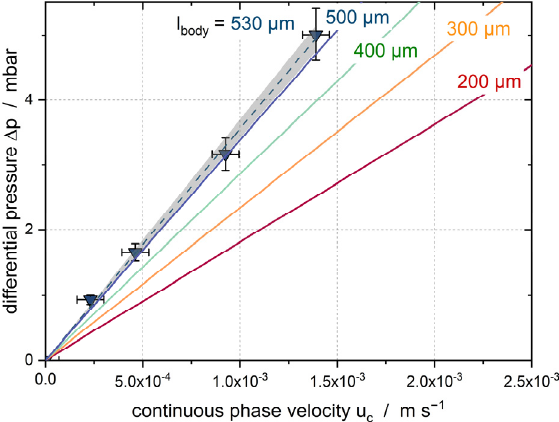
Figure 8. Experimental (data points) and simulations (lines) at ϑ exp = 17.5 ◦ C to outline the impact of the body length l body . The experimental data points were fitted linearly and the grey region represent the 95% confidence interval of this fit.